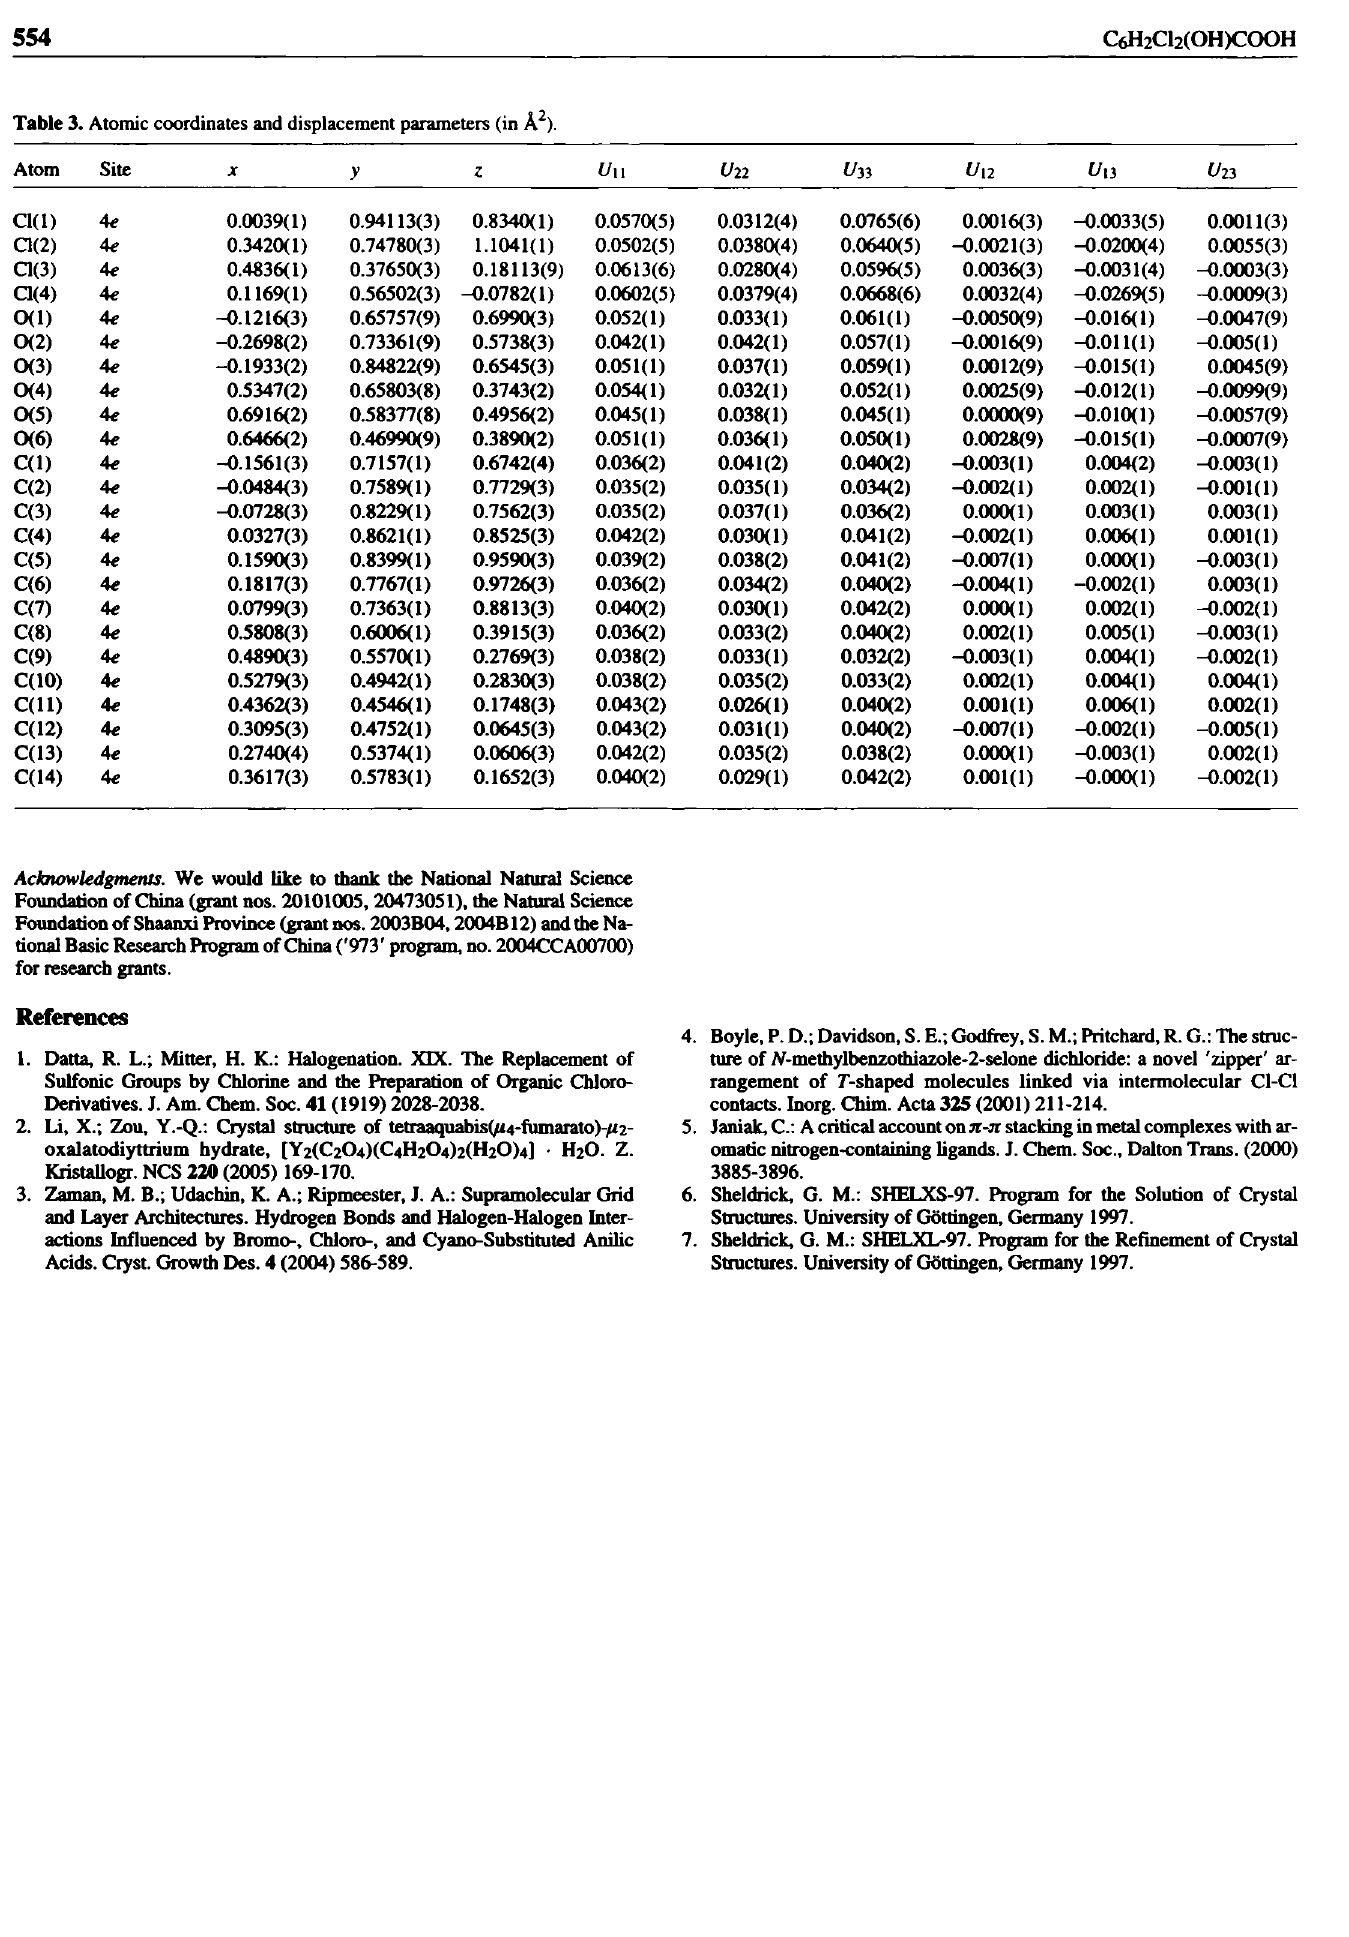
Table 3. Atomic coordinates and displacement parameters (in A 2